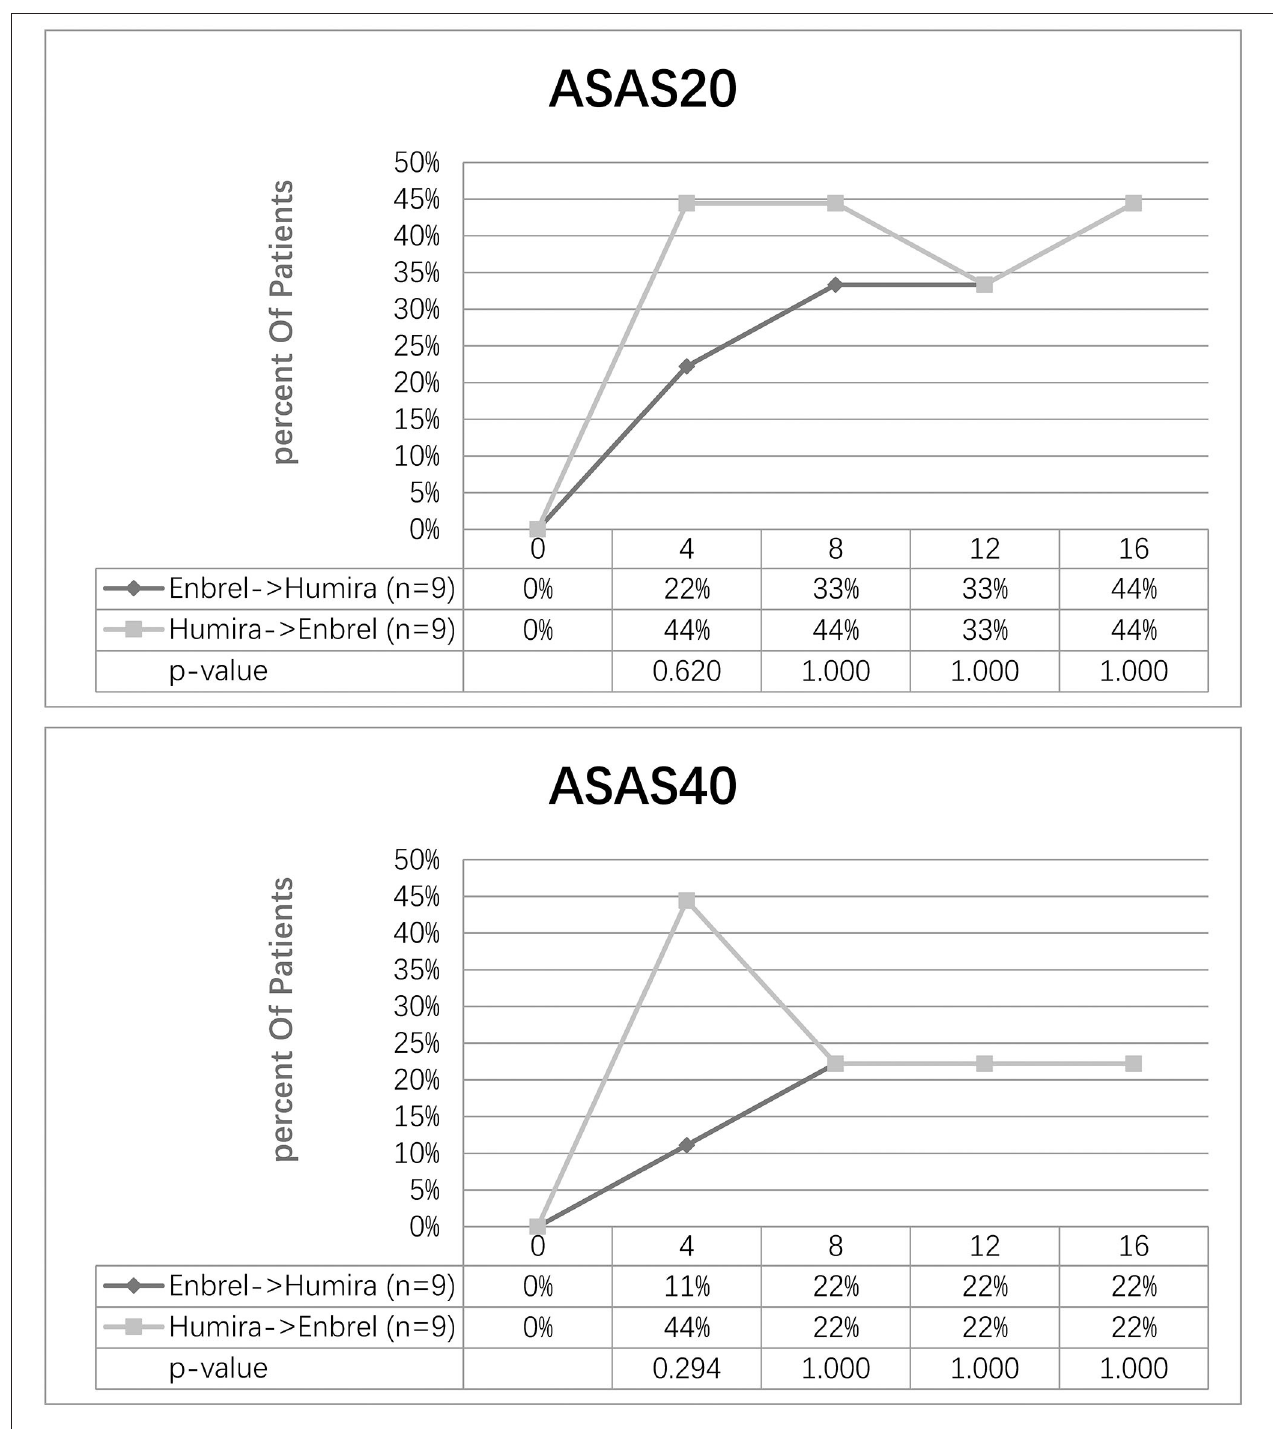
FIGURE 3 | Clinical response evaluated by ASAS20 and ASAS40 for the two arms. Percentage of patients achieving ASAS20 and ASAS40 at five-time visits from baseline to week 16 was